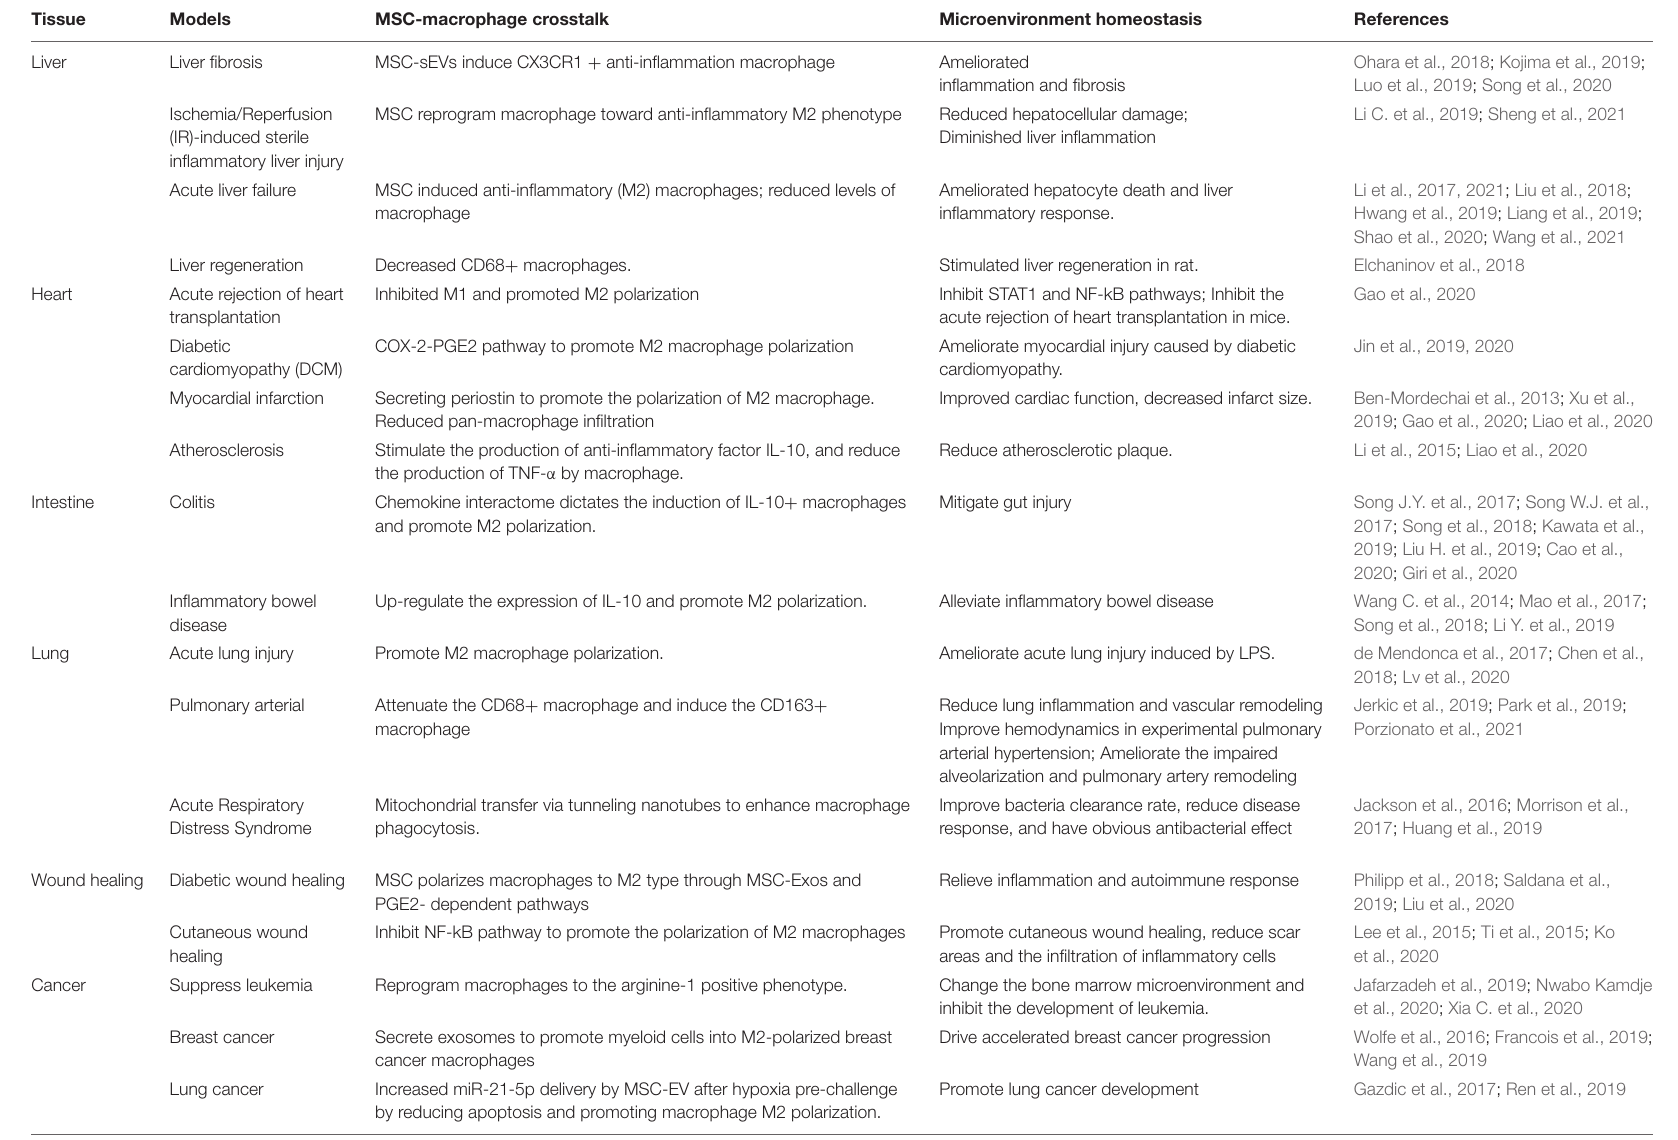
TABLE 1 | MSC-macrophage crosstalk in different diseases/ in vitro system.